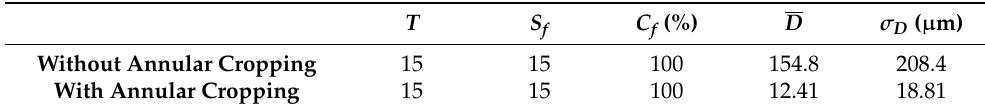
Table 5. MQI results for S 02 using a T 15/ S f 15 test combination without annular cropping and with annular